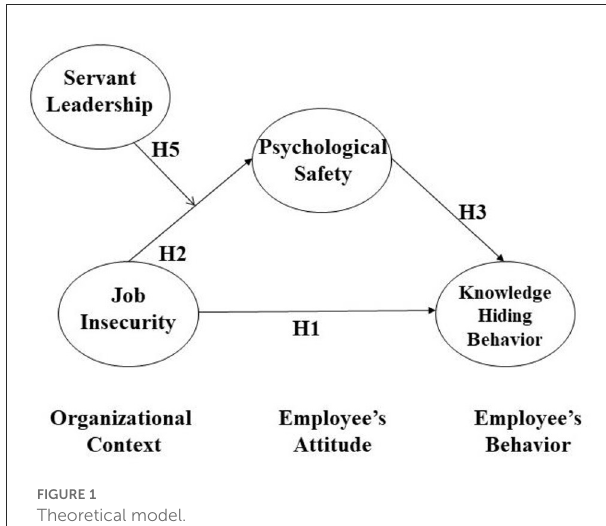
FIGURE1 Theoretical model.